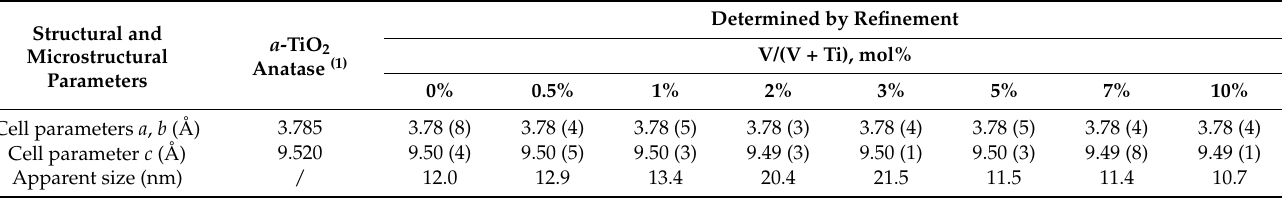
Table 1. Rietveld analysis of V-TiO 2 nanopowders with 0–10 mol% V calcinated at 450 ◦ C. Structural and Microstructural